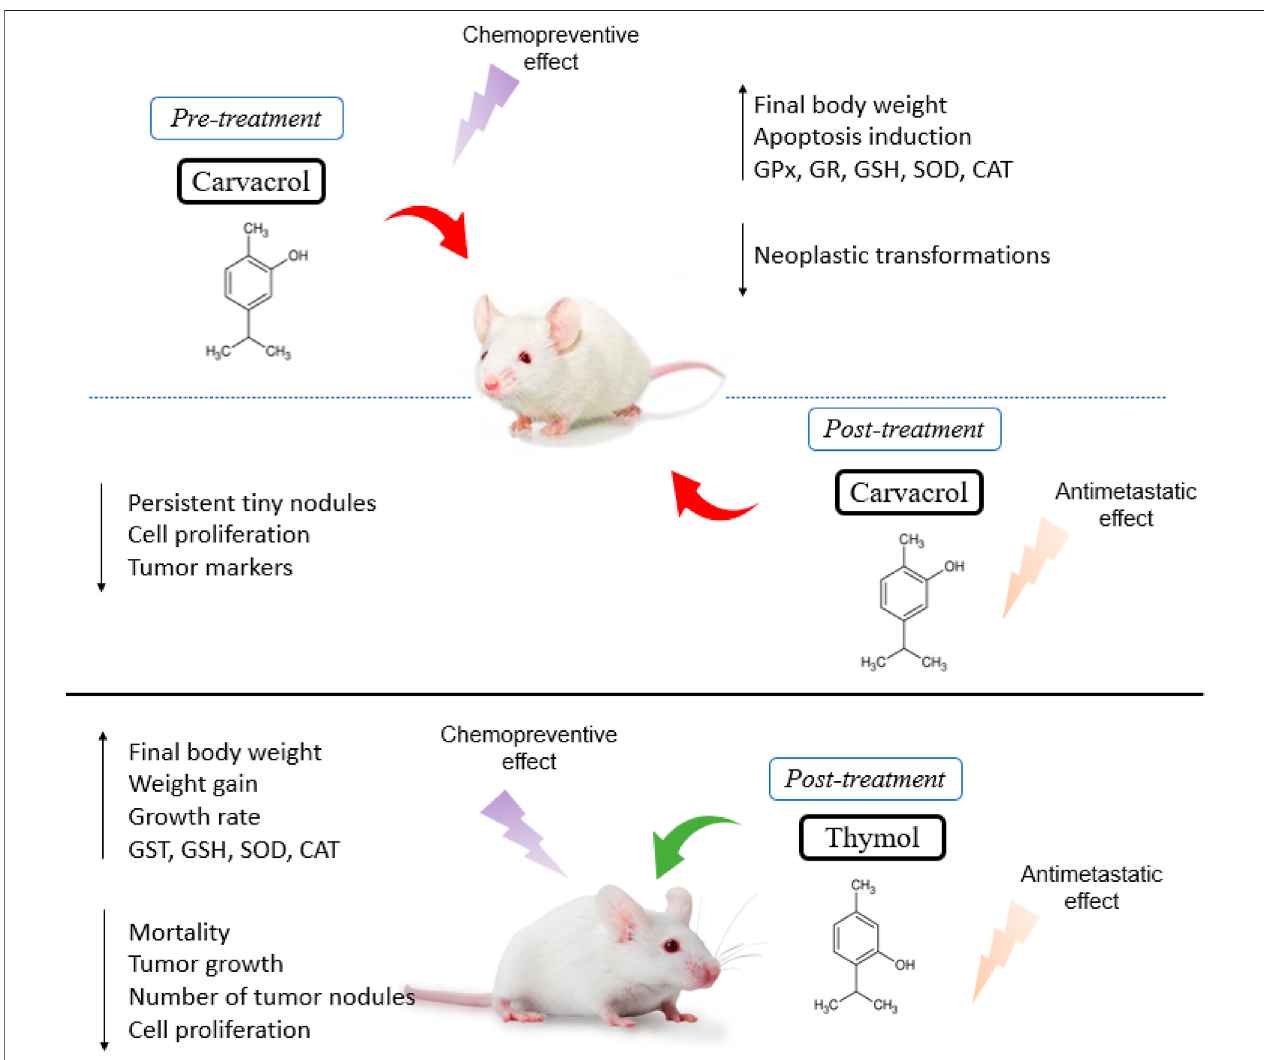
FIGURE 2 | Summary of main effects observed in in vivo